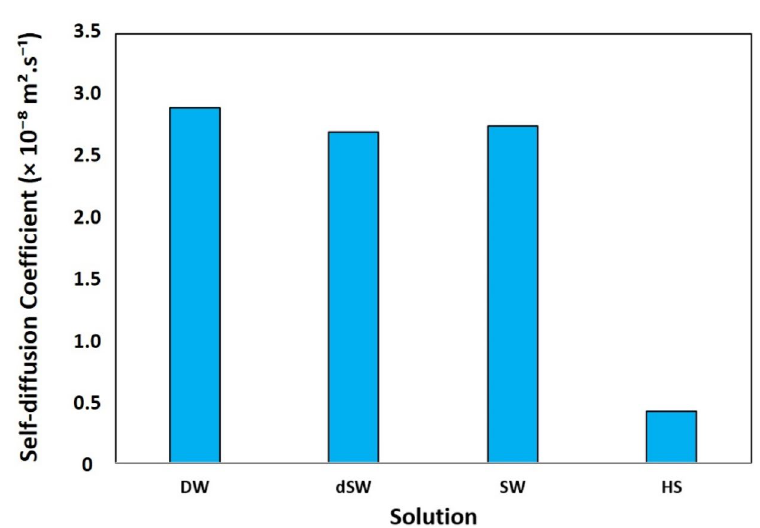
Figure 12. Self-diffusion coefficient of BA molecules in calcite/brine systems of different